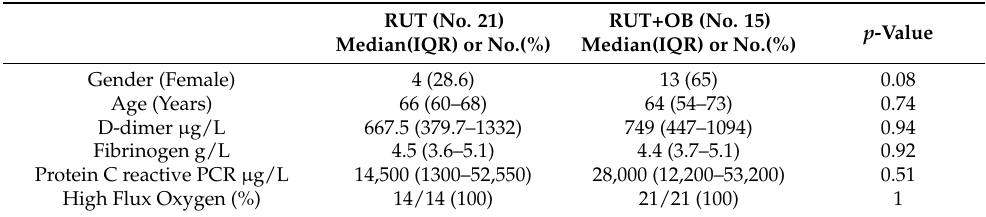
Table 1. Distribution of demographic and clinical variables between groups. A p-value ≤ 0.05 was considered statistically significant.